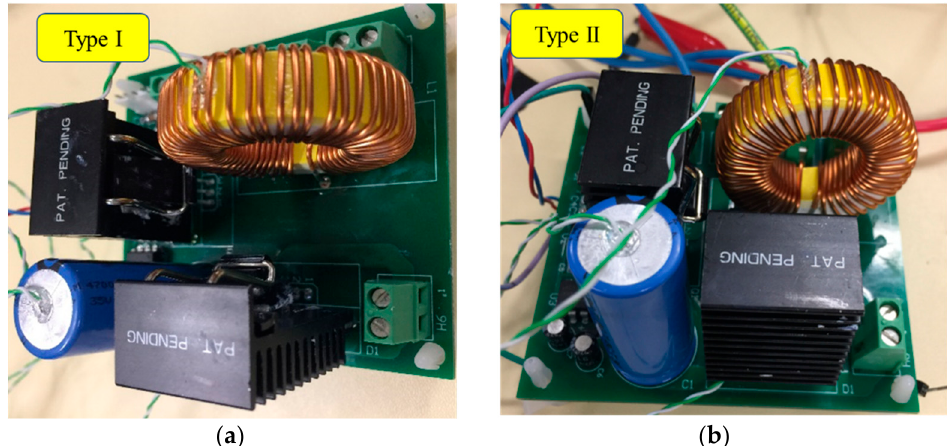
Figure 6. Two different types of power converters: ( a ) type I with large device spacing; ( b ) type II